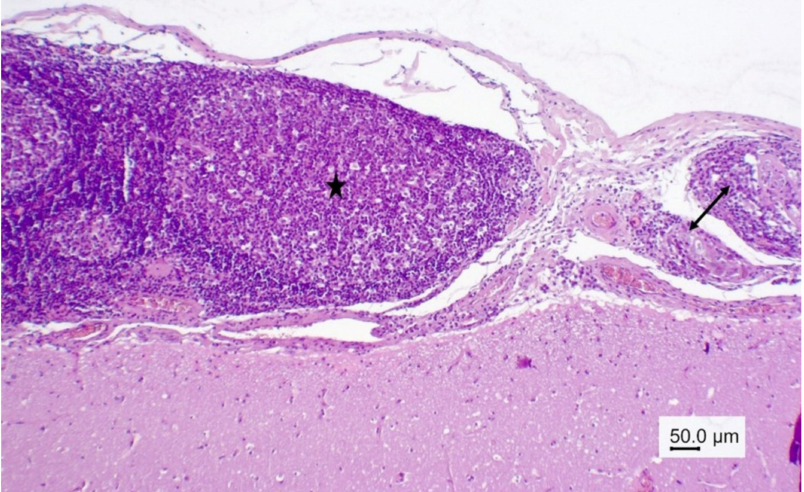
Figure 4. Wapiti, case 1, leptomeninges, histopathology, HE, × 40. Thickened and inflamed lep- tomeninges. Proliferation of lymphoid follicles with large germinal centers (star) in the leptomeninges on the left, vasculitis and perivasculitis on the right (double